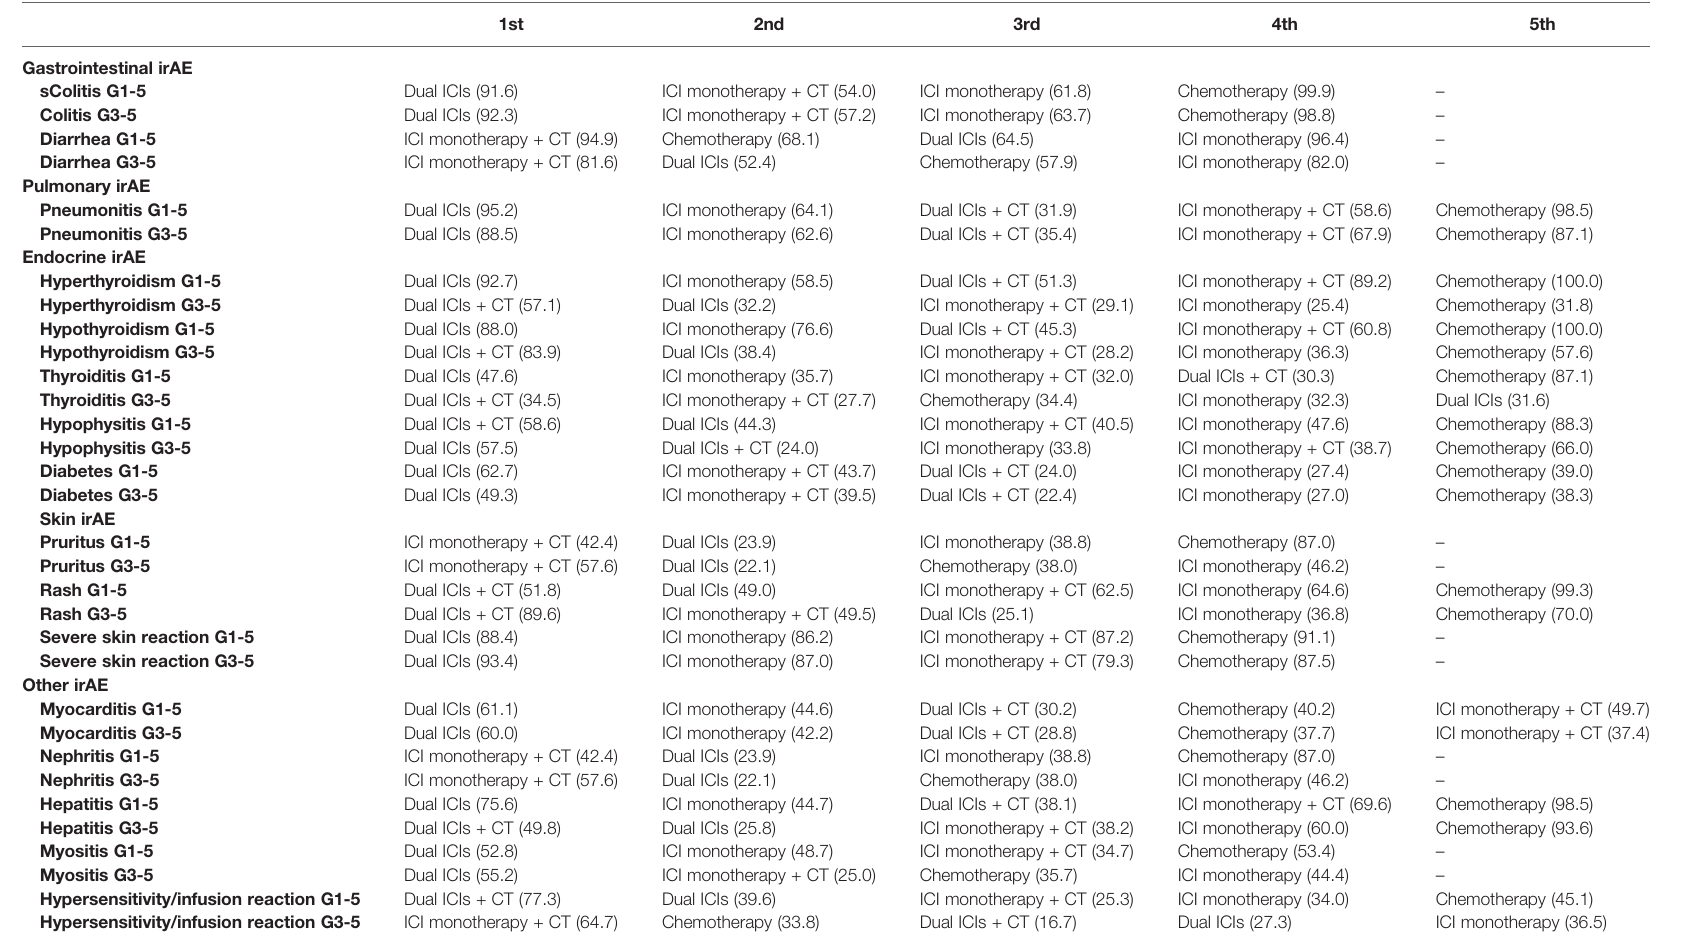
TABLE 3 | Toxicity spectra and rankings based on each speci fi c